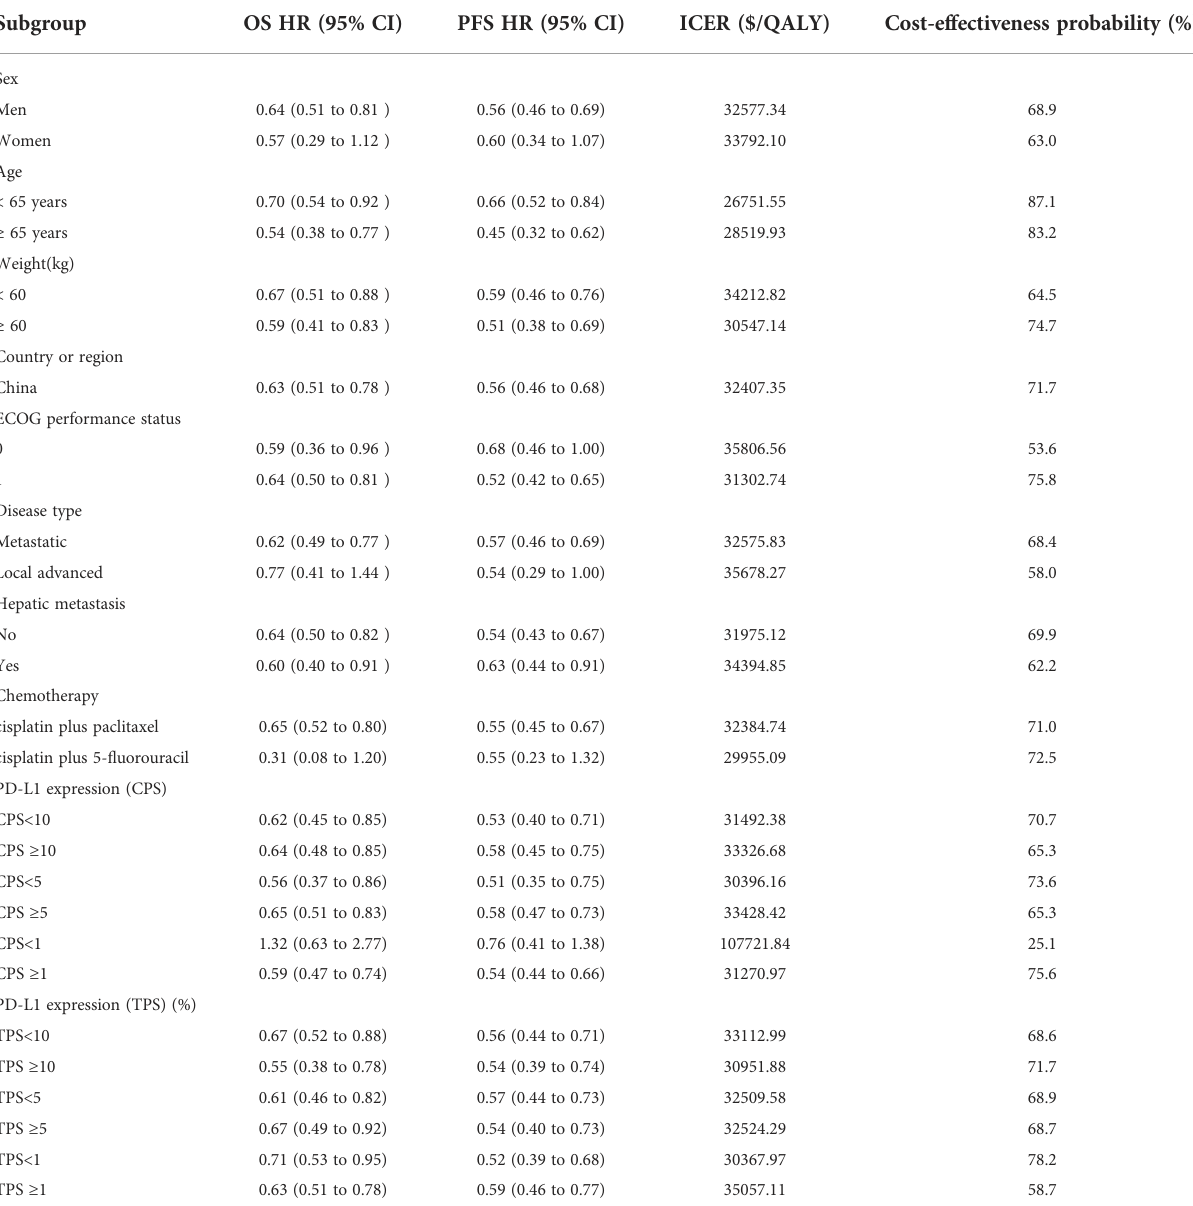
TABLE 4 Results of subgroup